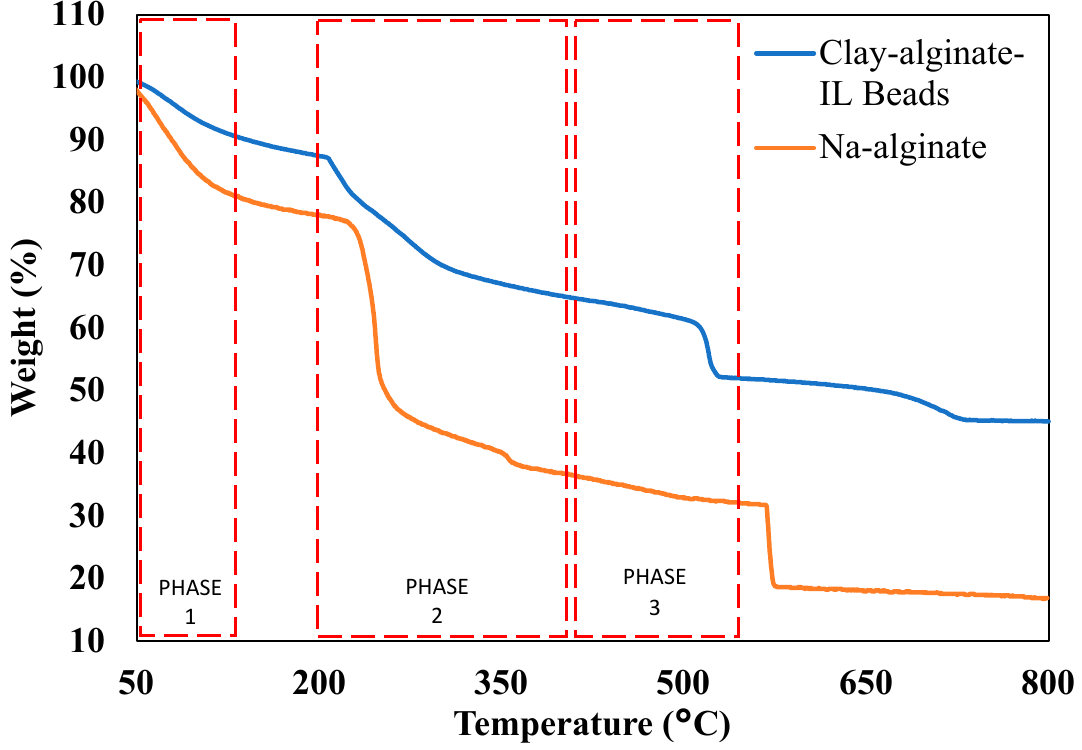
Figure 2. TGA of the clay-alginate-ILs beads and Na-alginate used in the adsorption process.